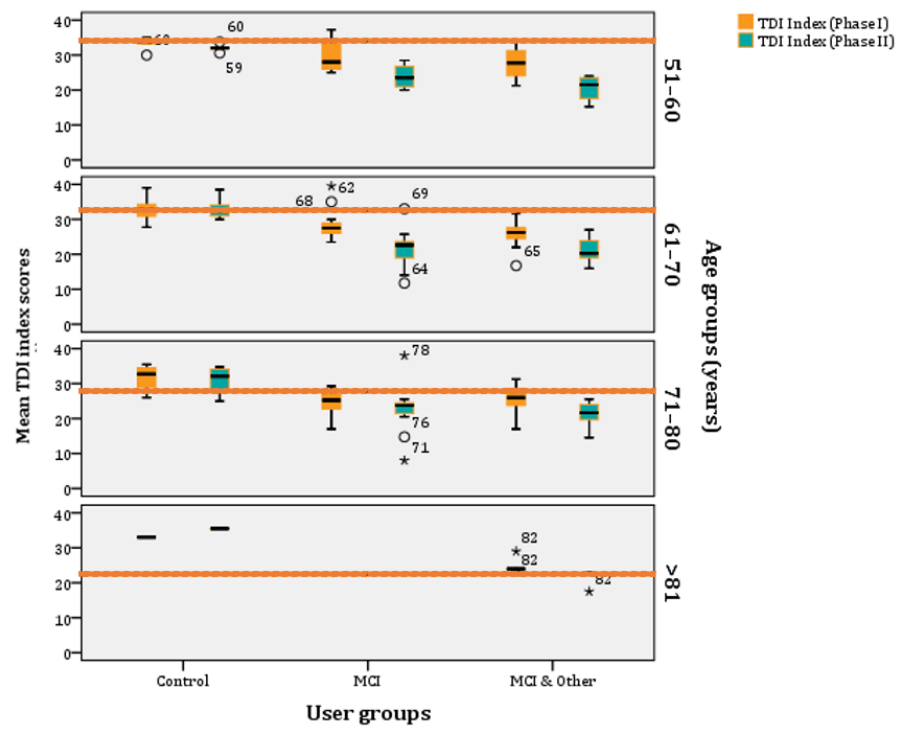
Figure 6. Age – stratified mean TDI index scores per experimental group (* stands for outliers). Figure 6. Age–stratified mean TDI index scores per experimental group (* stands for